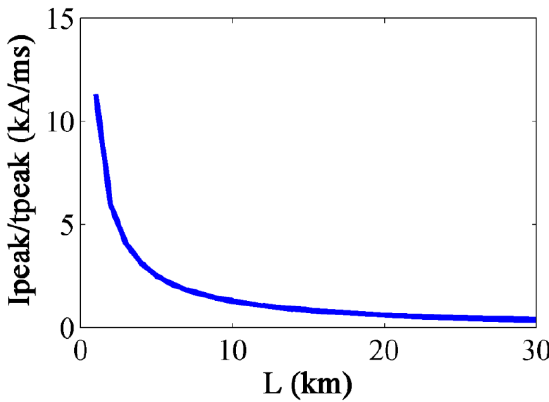
Figure 11. The ratio of the peak current to the time versus the fault